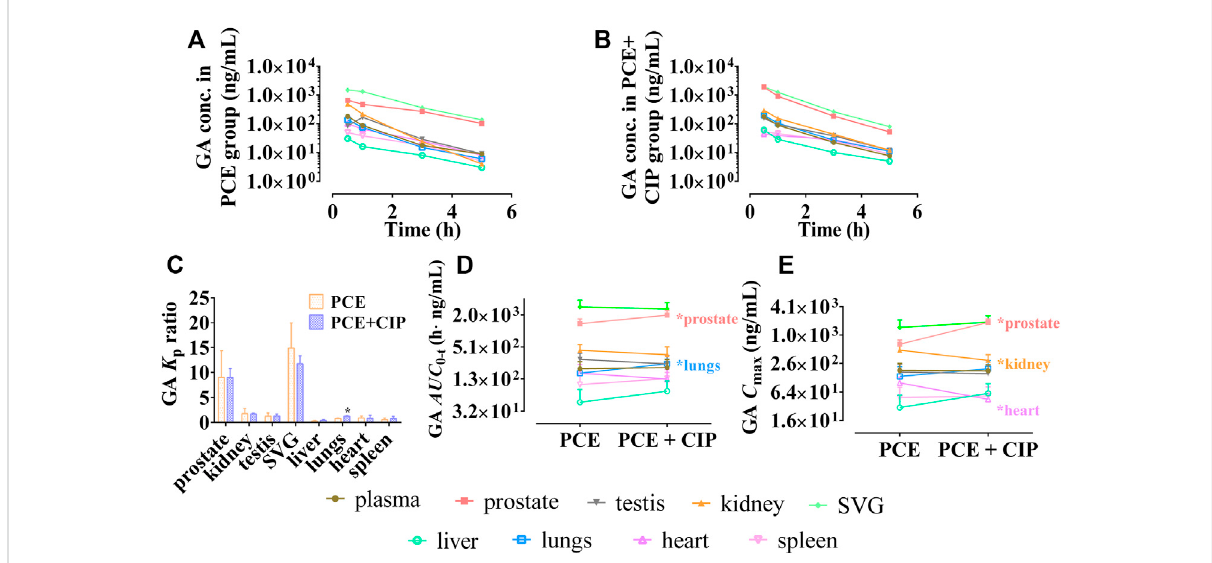
FIGURE 7 Tissue distribution pro fi les of gallic acid (GA) after oral administration of PCE in the absence (A) and presence (B) of cipro fl oxacin, as well as the tissue to plasma distribution coef fi cients [ K p , (C) ] and the distribution parameters including AUC 0-t (D) and C max (E) of GA (mean ± SD, n = 3).